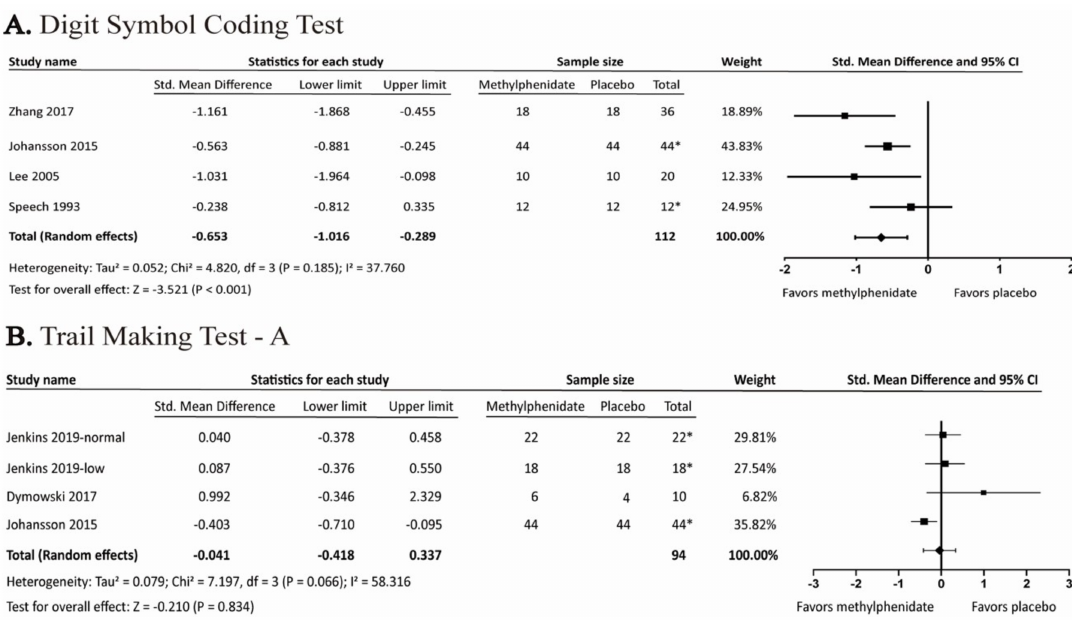
Figure 4. Forest plot of the e ff ects of methylphenidate in ( A ) Digit Symbol Coding Test and ( B ) Trail Making Test, part A. *: crossover